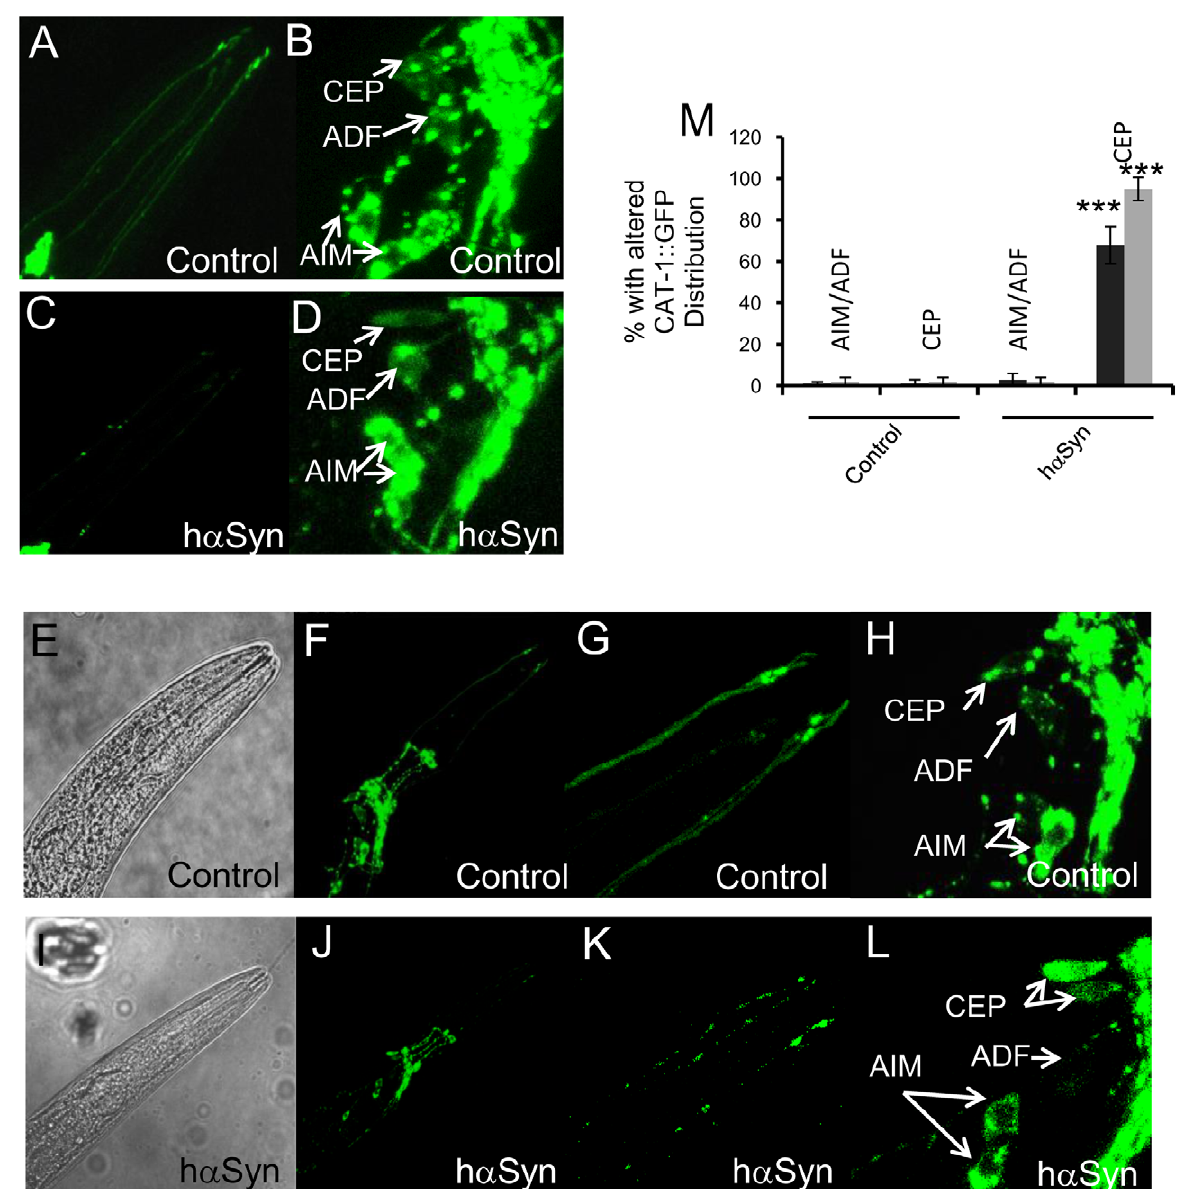
Figure 4. h a Syn expression disrupts dopamine synaptic vesicle distribution. A–L, Typical confocal laser scanning VMAT/CAT-1::GFP (A–D, F–H, J–L) or bright field (E, I) images of living L2 (A–D) or L4 (E–L) nuls26 (a worm line expressing VMAT-CAT-1::GFP) worms expressing (C–D, I–L) or not expressing (A–B, E–H) h a Syn. A–D, are GFP images that show DAergic (CEP, specifically) dendrites (A, C) or DAergic/serotonergic somas (B, D) of L2 worms. G and K are magnified areas of F and J, respectively, that show DAergic dendrites (CEP) of L4 worms. H and L, are magnified areas of F and J, respectively, that show DAergic and serotonergic somas of L4 worms. M, Quantification of CAT-1::GFP redistribution in DAergic neurons (CEP) and serotonergic neurons (AIM and ADF) of L2 (black bars, n=5) and L4 worms (gray bars, n=8). ***: p , 0.0001 (t-test). Error bars indicate